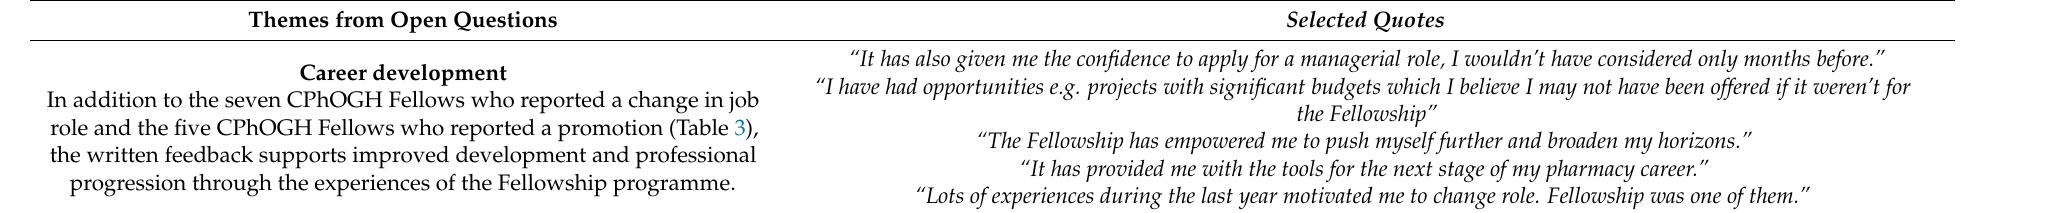
Table 5. Themes from Open questions in the post-CPhoGH Fellows